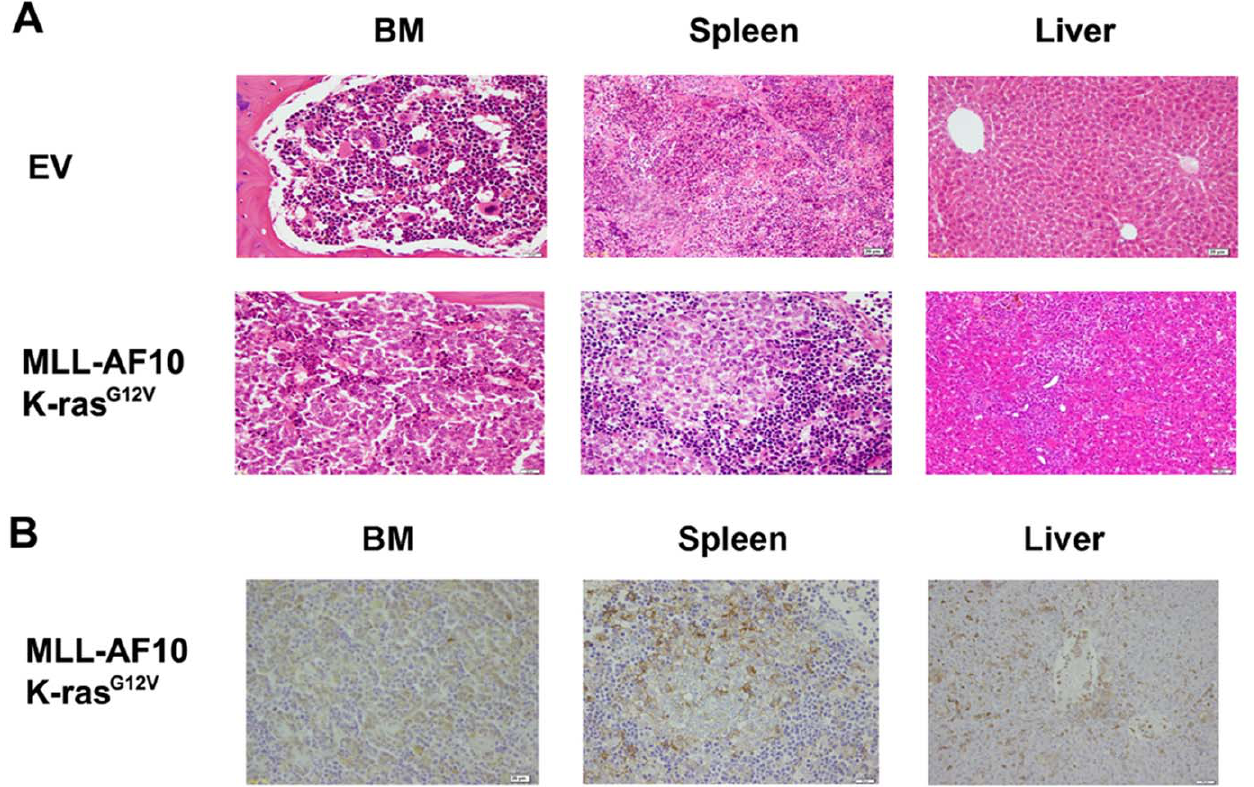
Figure 6. Pathological phenotypes of the leukemia. (A) Hematoxylin and eosin staining showing the infiltration of leukemic cells in the indicated organs of mice engrafted with HSCs expressing the MLL-AF10 and K-ras G12V genes compared to control mice. (B) Immunostaining by a human CD45 mAb in the BM, spleen, and liver in mice engrafted with HSCs expressing the MLL-AF10 and K-ras G12V genes.